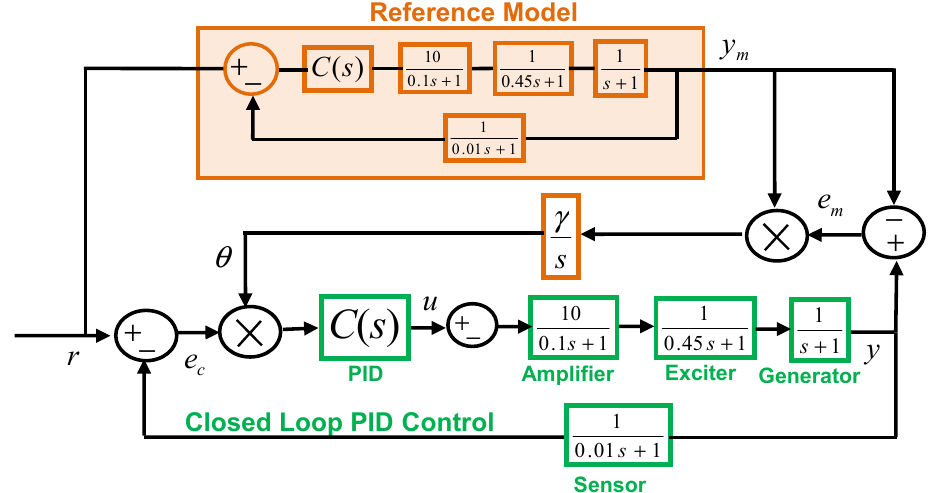
Figure 7. ML-MR PID-MIT-CGM control structure with control gain shaping that is implemented for improvement of the disturbance rejection performance of an optimal closed loop PID control of an AVR model.